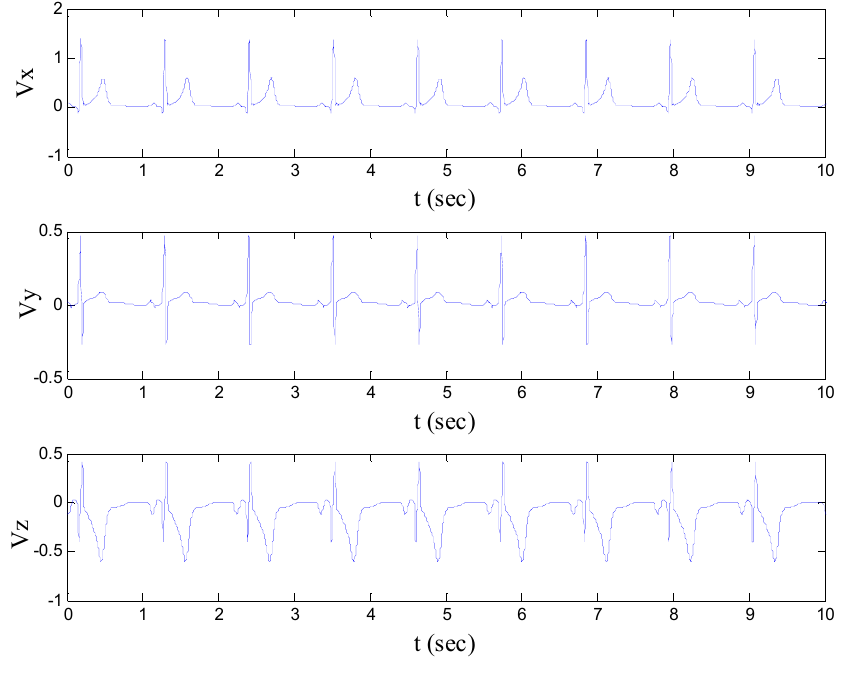
Figure 3. Synthetic ECG signals.